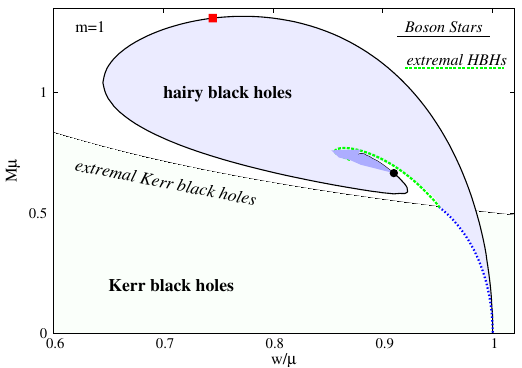
Figure 3 . Fundamental rotating boson star solutions with m = 1 (black solid line) in a mass vs. scalar (cid:12)eld frequency diagram (in units of (cid:22) ). The hairy black holes exist within the blue shaded region. The swampland criteria fail to be satis(cid:12)ed inside the darker shaded region. m 2 Z . Again, a stable branch against perturbations is expected to exist between the maximal frequency and the maximal ADM mass | see [78] for a discussion and